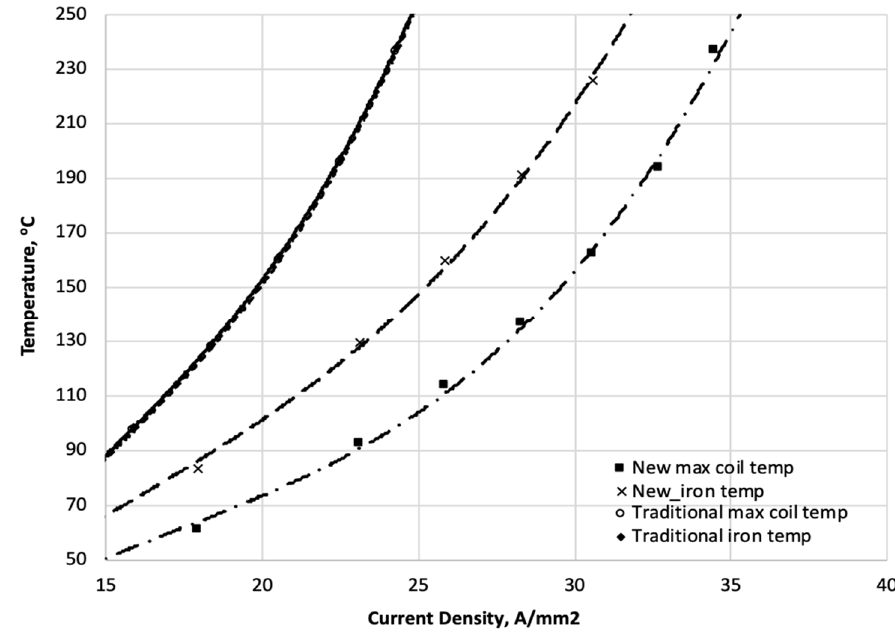
Figure 18. Comparison of the current density and coil temperature of a traditional coil and the new construction.